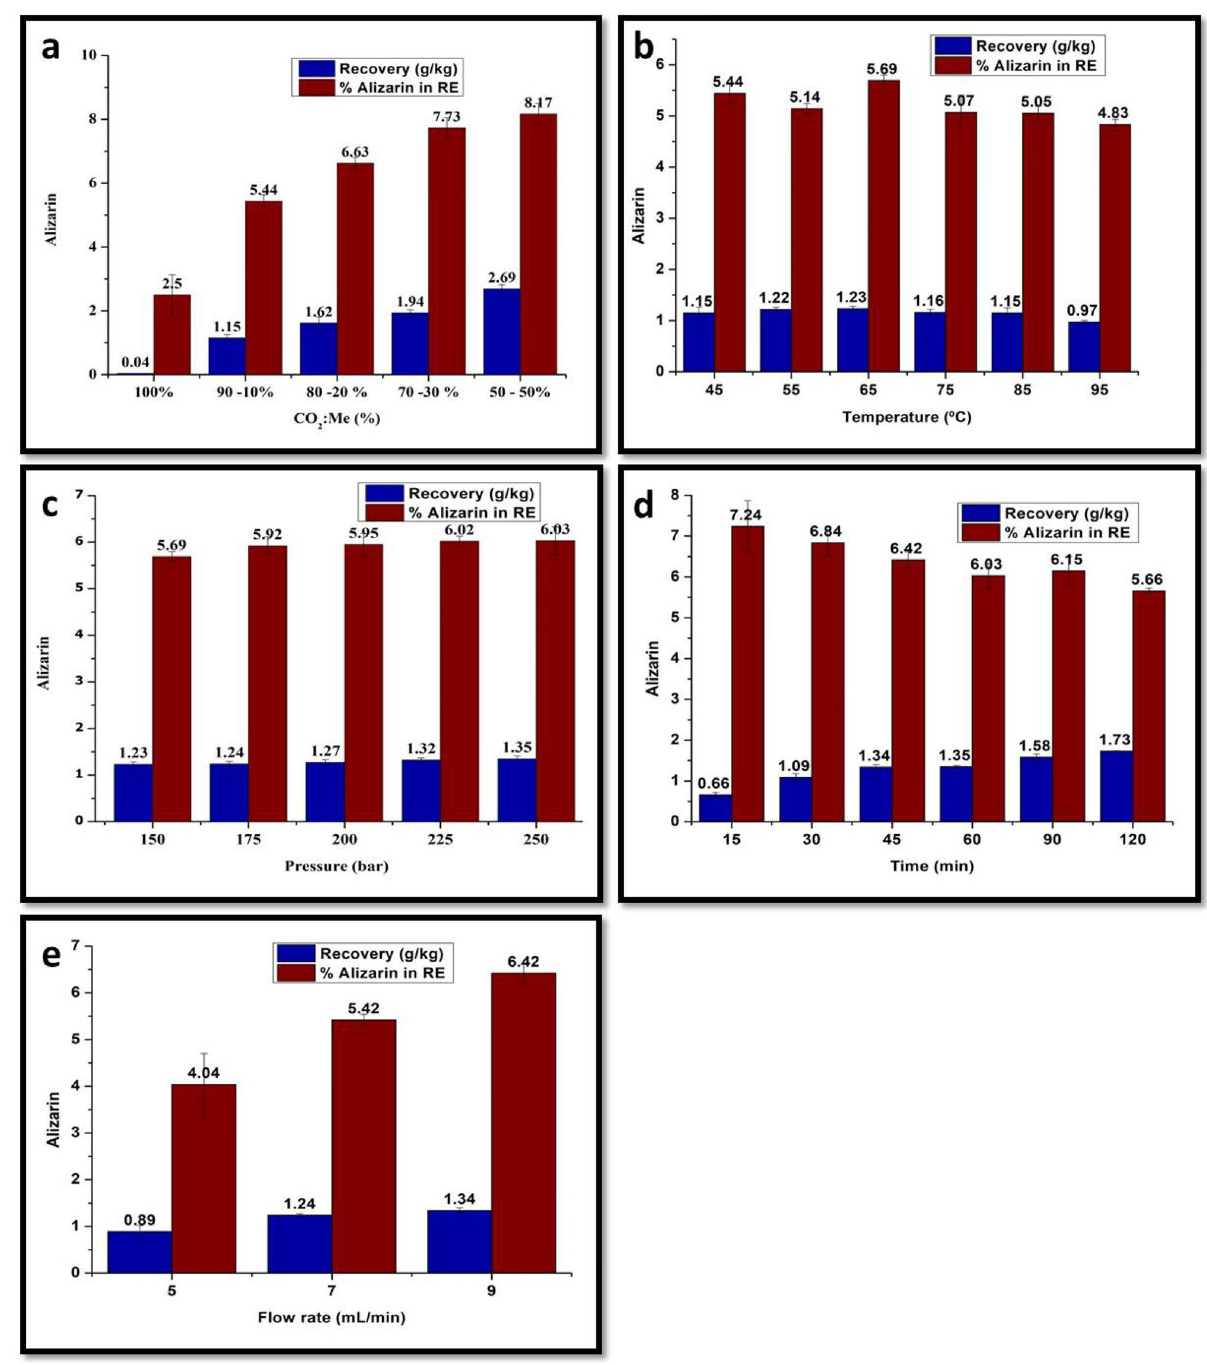
Figure 1. Effects of ( a ) solvent composition ratio, ( b ) temperature, ( c ) pressure, ( d ) extraction time, ( e ) flow rate on alizarin recovery (g/kg roots), and alizarin content (%) in ciency of alizarin, dried R. tinctorum roots were extracted under various pressure levels (150, 175, 200, 225, and 250 bar). The co-solvent ratio, temperature, extraction time, and flow rate were all constant at 90 CO 2 :10 Me, 65°C, 60 minutes, and 9 mL/min, respectively. As pressure increased, alizarin recovery increased. Under 150 bar pressure, alizarin recovery from R. tincto‑ rum roots was approximately 1.23 g/kg roots and increased to 1.34 g/kg under 250 bar pressure. In addition, the alizarin content in the RE With an increase in pressure from 150 bar to 250 bar, the alizarin content in the RE increased from 5.69 to 6.18% (Fig. 1 and Table 1). The density and diffusivity of CO 2 increased with increasing pressure. By increasing pressure, the fluid interacts with the matrix, which improves the solubility and extraction efficiency of alizarin. Based on the optimization study of other extraction parameters, including time and flow rate, the optimum pressure level of 250 bar was selected to maximize alizarin extraction efficiency .